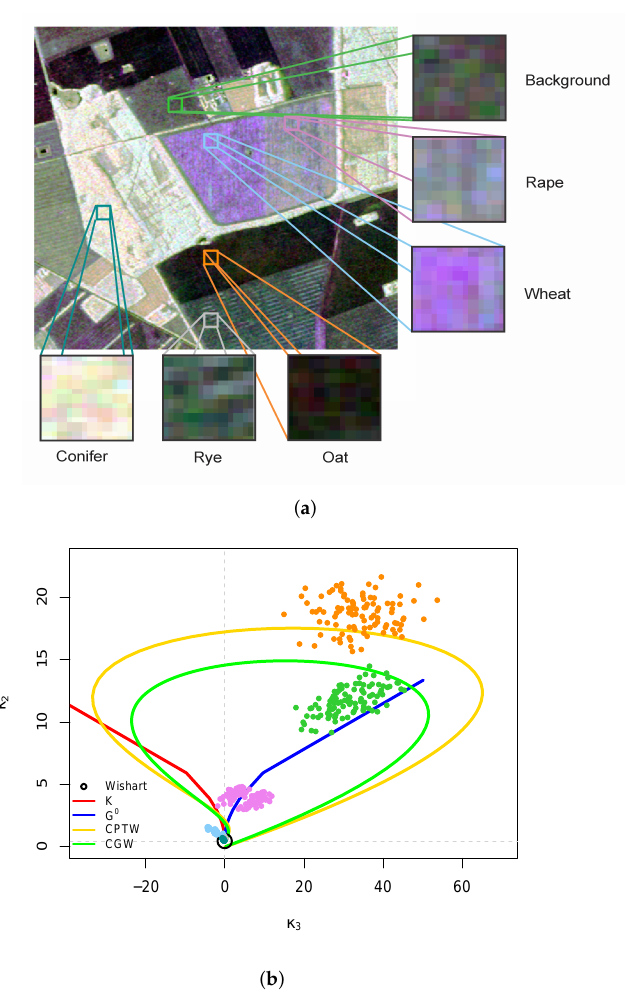
Figure 9. MLC diagram with sample MLCs computed from the samples of Foulum. ( a ) Subset areas of Foulum [36]. ( b ) MLC diagram with sample MLCs computed from the samples in ( a ). Figure 10c highlights five crop scenes: winter barley (purple), sugar beet (gray), winter wheat (dark green), winter rape (brown) and maize (light blue). The s W presented the best fit for three last scenes. The two proposed models furnished the best description for Winter